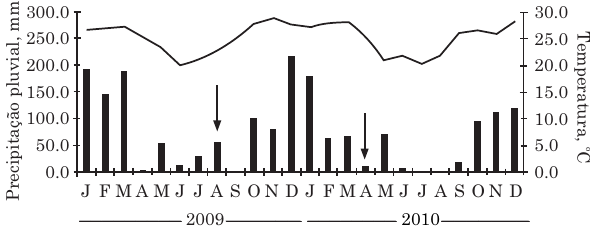
Figura 2. Precipitação pluvial e temperatura durante os dois anos hidrológicos de condução dos estudos, no Pantanal da Nhecolândia, MS. Dados coletados na estação meteorológica da Embrapa Pantanal. Setas indicam o mês de